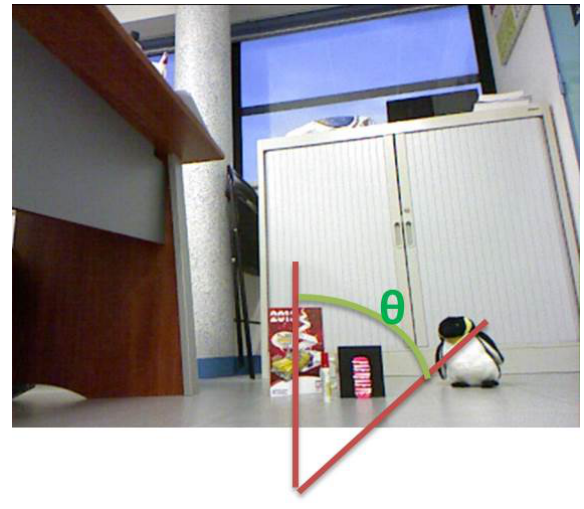
Figure 7. Definition of θ , the angle between the normal direction given by the Kinect and the focus of